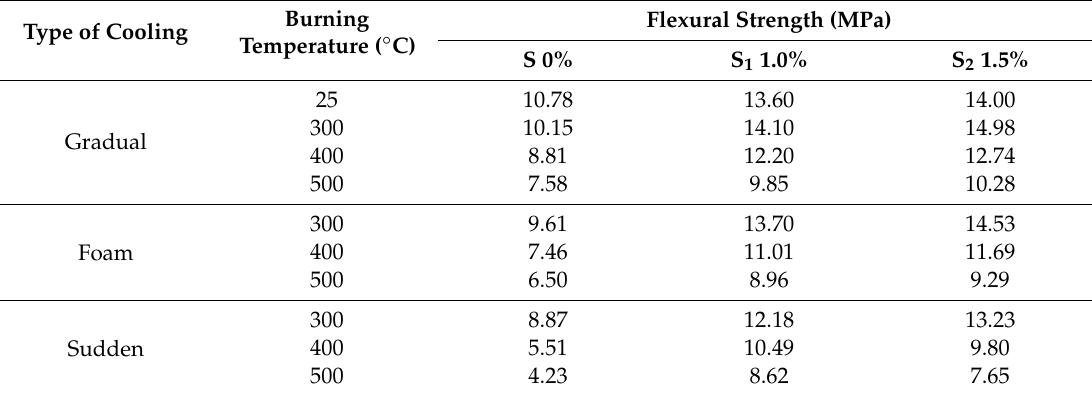
Table 11. Flexural strength results concerning all types of cooling for the adopted (RPC)